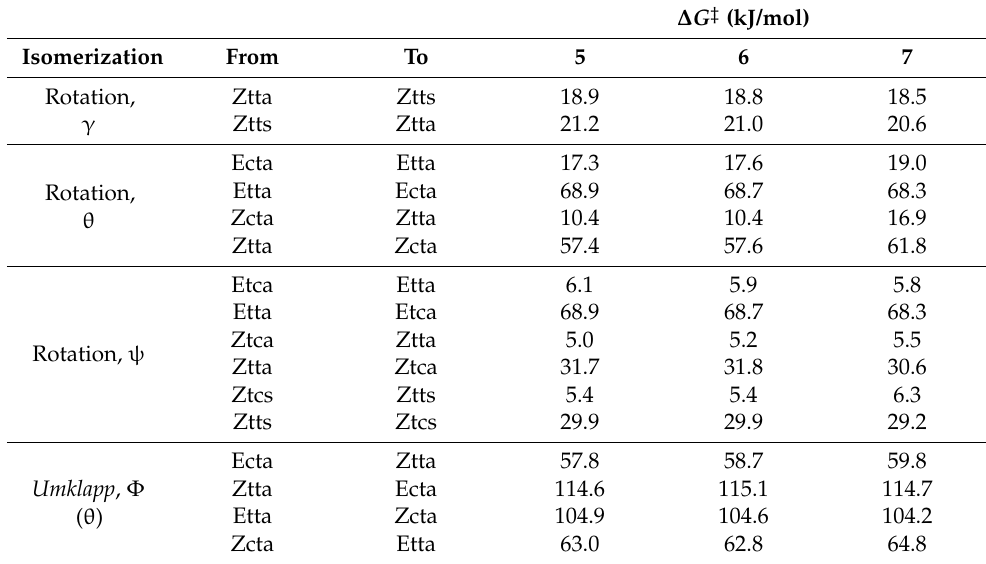
Table 11. Free energy activation barriers, ∆ G ‡ , calculated at the ω B97M-D4/cc-pVTZ level, and corresponding rate constants at 298 K for selected isomer interconversion processes of 5 – 7 . The barriers are grouped with respect to the interconversion